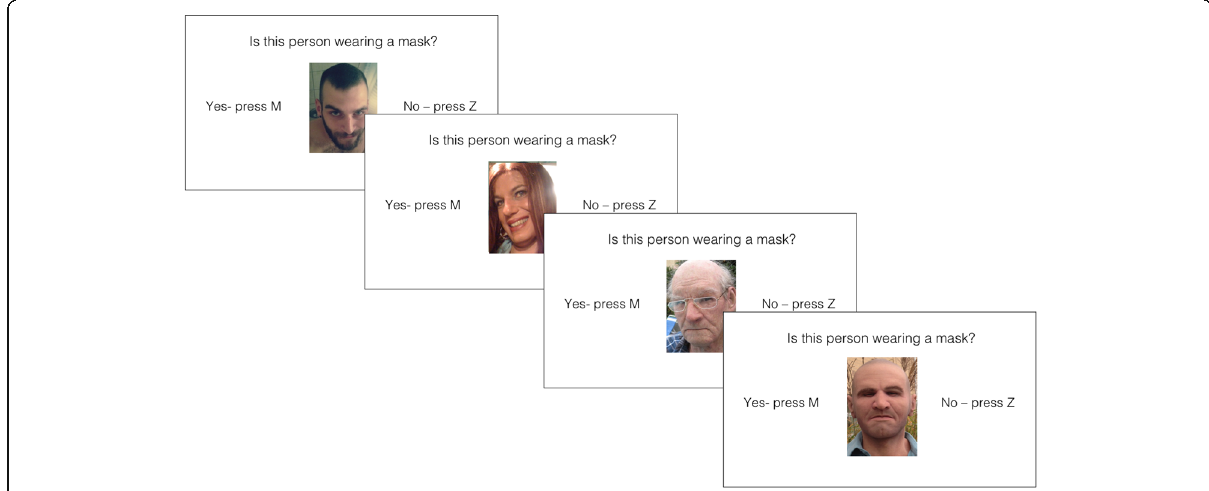
Fig. 5 Example of trial sequence in Study 2. Correct responses: Z, Z, M,